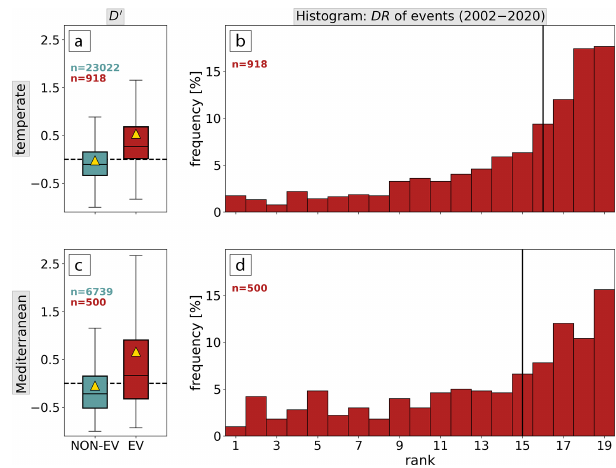
Figure D1. Event comparison for (a, b) the temperate and (c, d) the Mediterranean biome in the period 2002–2020. (a, c) Boxplots of the disturbance anomaly D (cid:48) of low-NDVI grid cells (red) and non- event grid cells (turquoise). The distribution mean is shown by a yellow triangle; outliers are omitted. (b, d) Histograms of ranks 1– 19 of disturbance area DR of low-NDVI grid cells in 2002–2020. The median is shown by the vertical